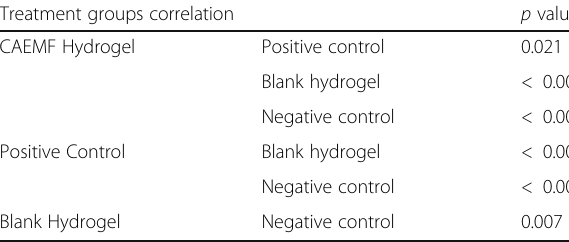
Table 2 p- values of the treatment groups Treatment groups correlation p value CAEMF